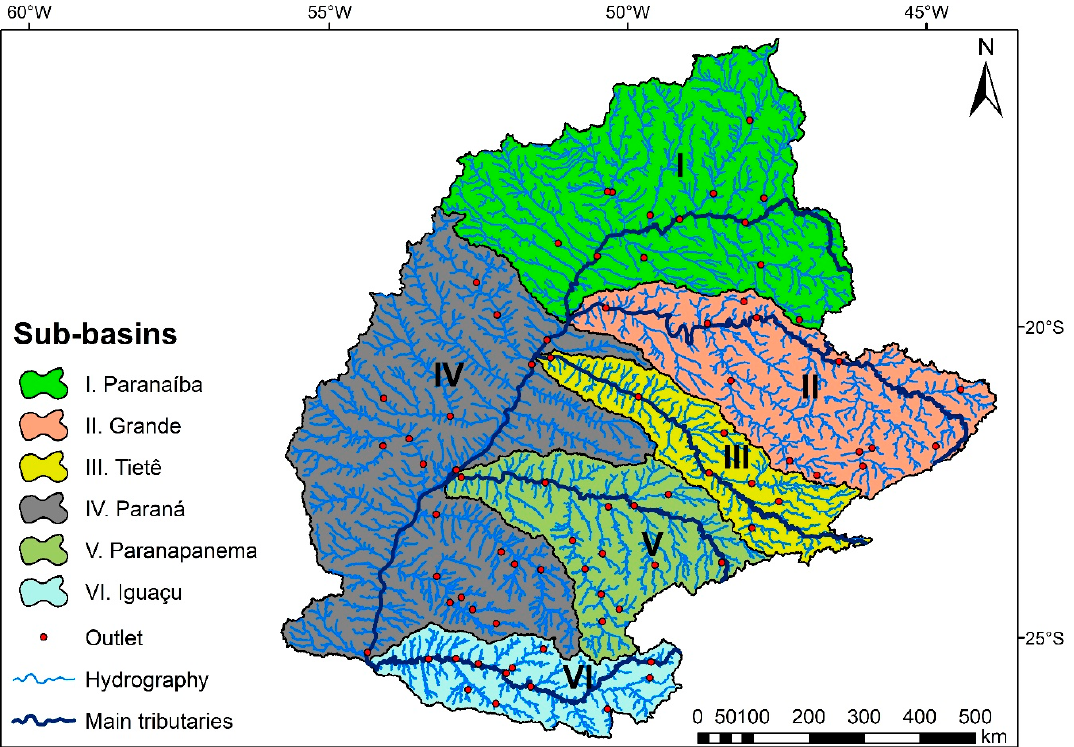
Figure 3. UPRB with its sub-basins showing the spatial distribution of fluviometric stations.